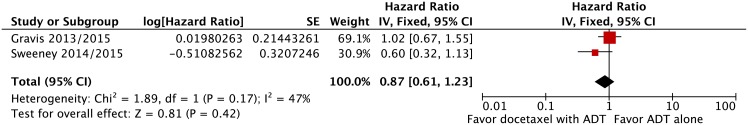
Comparative effect in overall survival of ADT with docetaxel versus ADT alone in patients with low-volume disease.Abbreviations: ADT, androgen-deprivation therapy; CI, confidence interval.